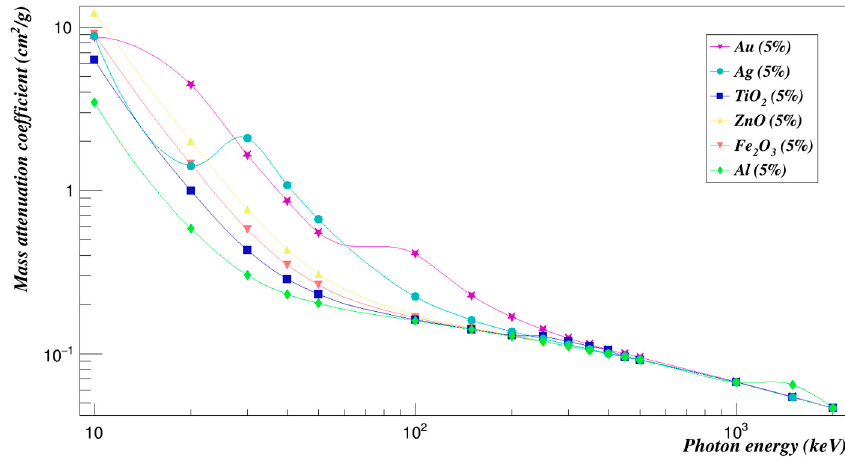
Figure 16. Mass attenuation coefficients of Polyimide doped with 5% of different composites.